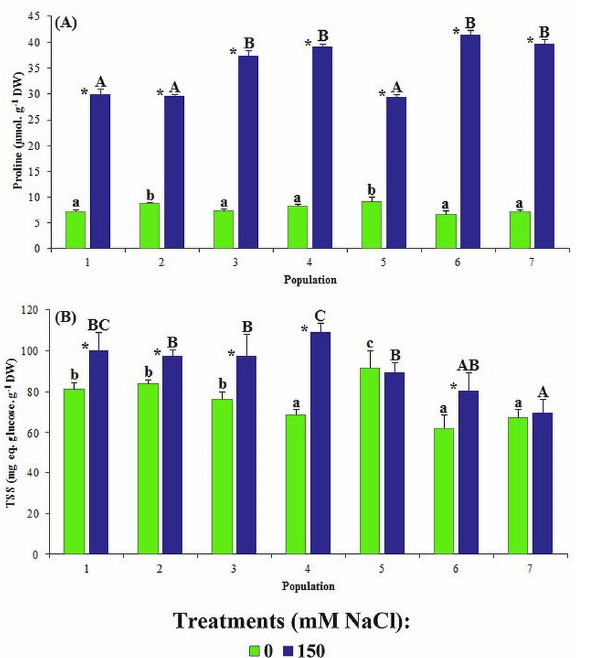
Fig. 5. Oxidative stress and antioxidant responses in the seven studied populations of Romanian larch. (A) Malondialdehyde (MDA) contents expressed in nmol g -1 DW; (B) Total Phenolic Compounds (TFC) expressed as mg eq. of gallic acid g -1 DW; (C) Total Flavonoids (TF) expressed as mg. eq. of cathechin g -1 DW. Values shown are means ± SE (n = 5). Different letters over the bars (lower case for controls and capital letters for salt stressed plants) indicate significant differences between different populations according to Tukey test (α = 0.05). Asterisks (*) indicate significant differences between salt- treated and control seedlings of the same population. Populations are given number codes according to Table